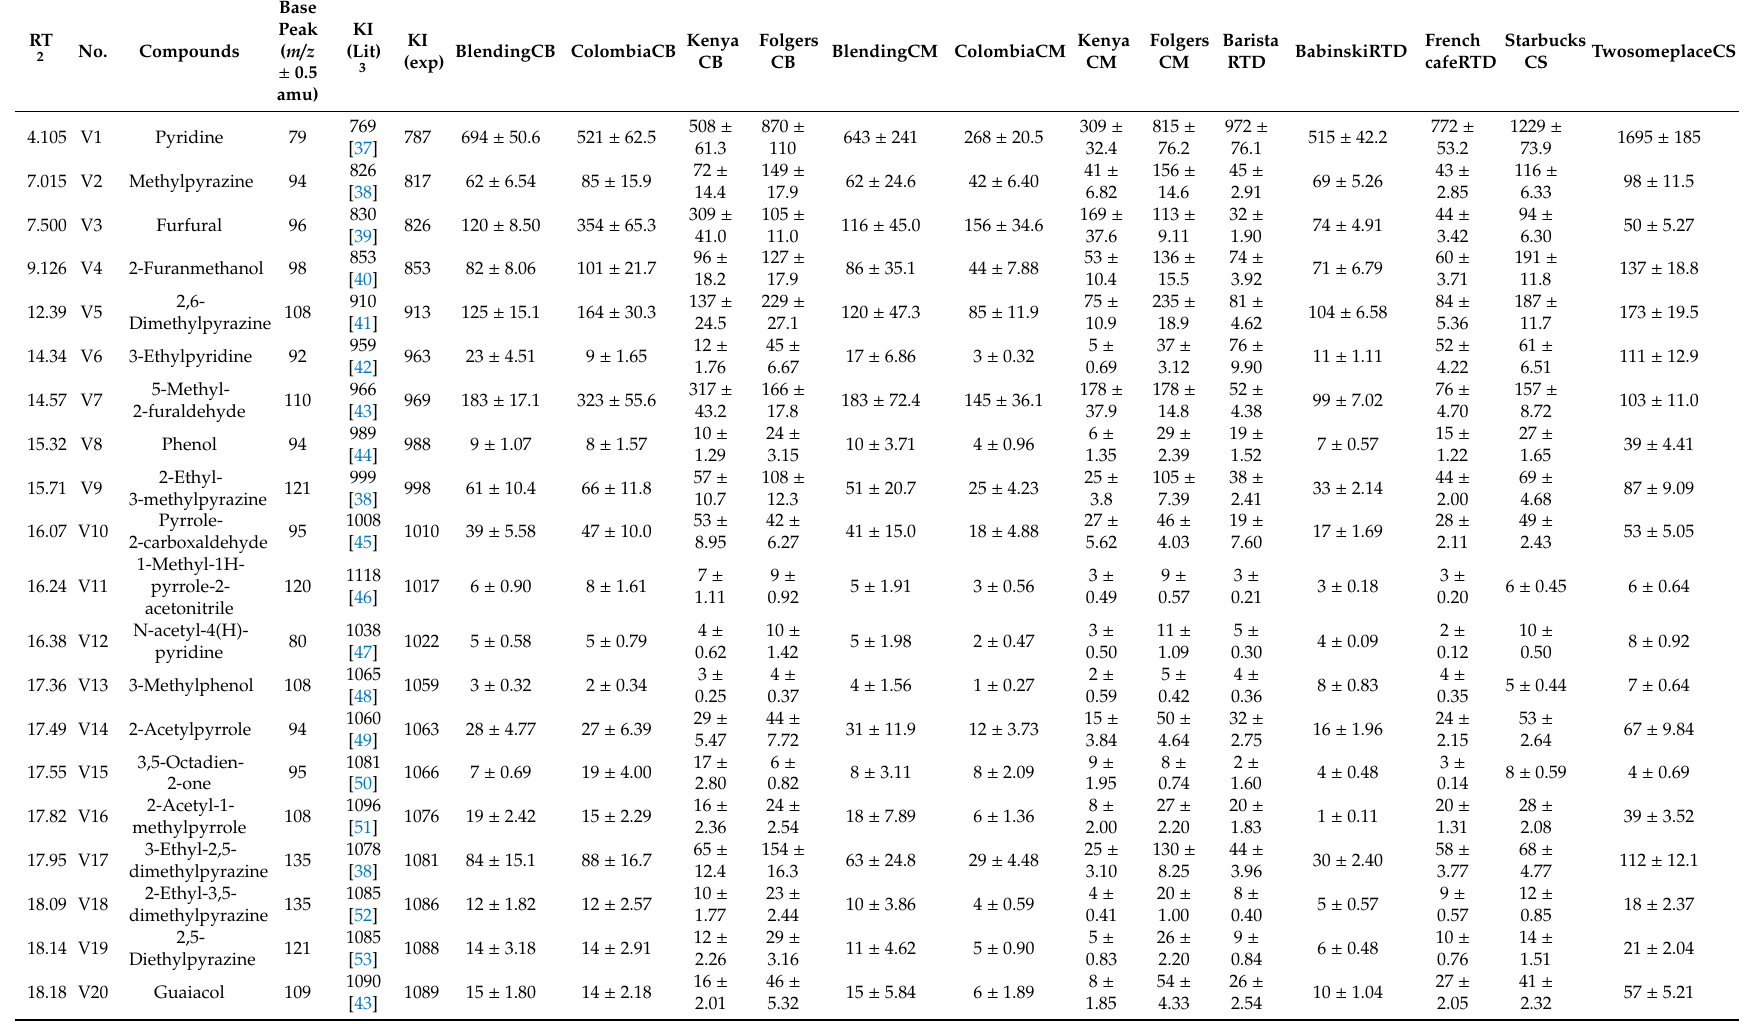
Table 4. Concentration of volatile compounds of co ff ee samples (ng / mL) 1